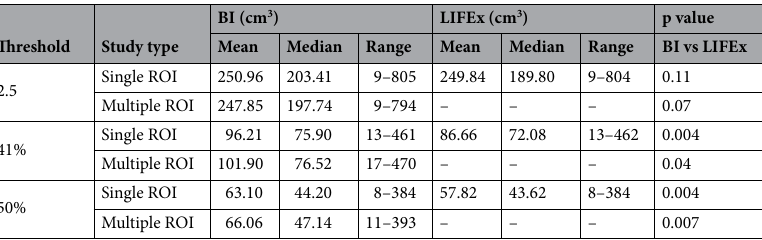
Table 3. Single ROI study vs multiple ROI study. For the multiple lesion affected patients, values obtained in multiple ROI drawing in BI were compared to the ones obtained in single ROI drawing in LIFEx. P values compared the mentioned pair of data.